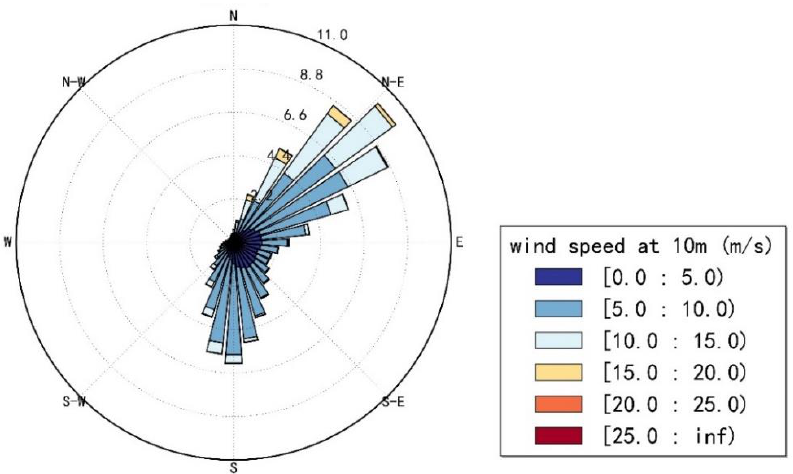
Figure 11. Rose plot of wind speed at the Xisha Islands.